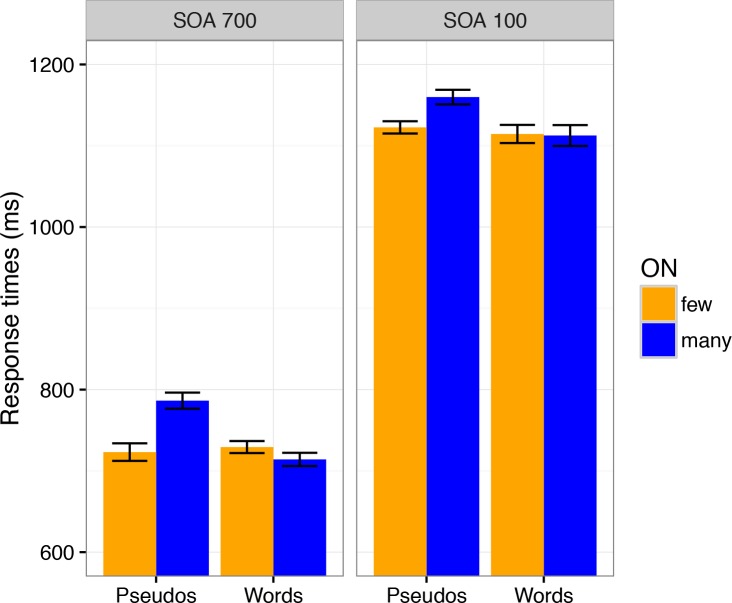
Response times as a function of stimulus onset asynchrony (SOA), lexicality (words versus pseudowords) and orthographic neighborhood size (ON).Error bars show SEMs after removal of the irrelevant overall between-subject differences (based on [68]).